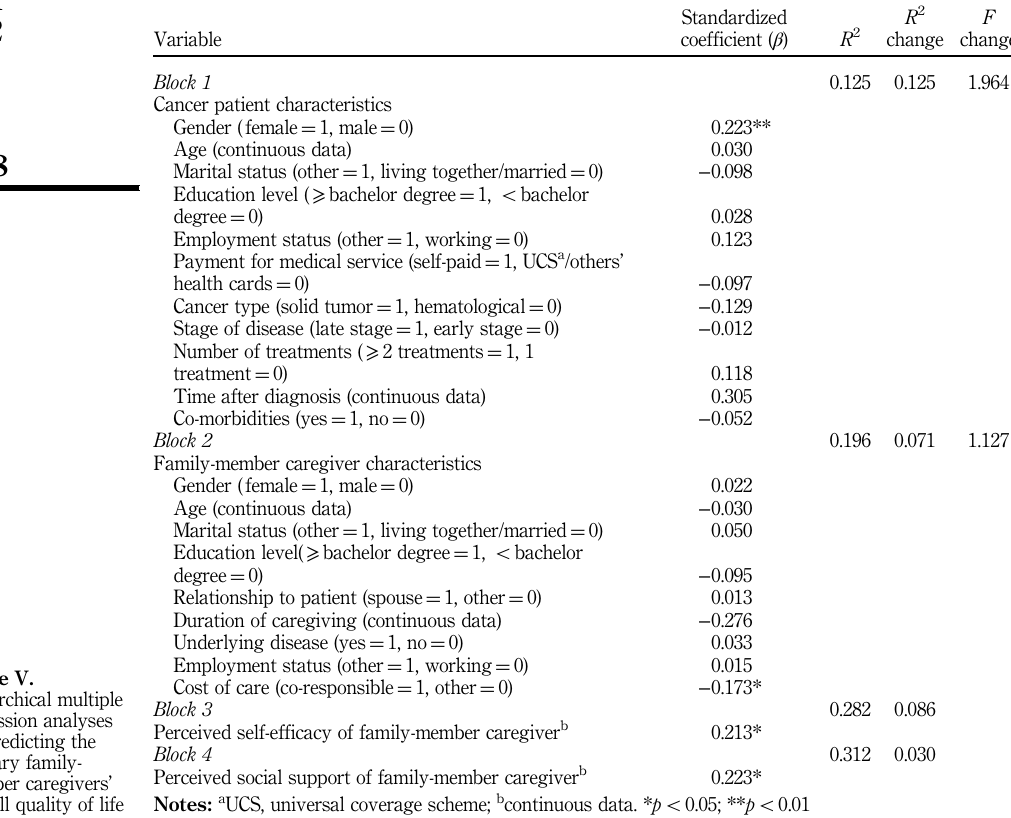
regression analyses for predicting the primary family- member caregivers ’ overall quality of